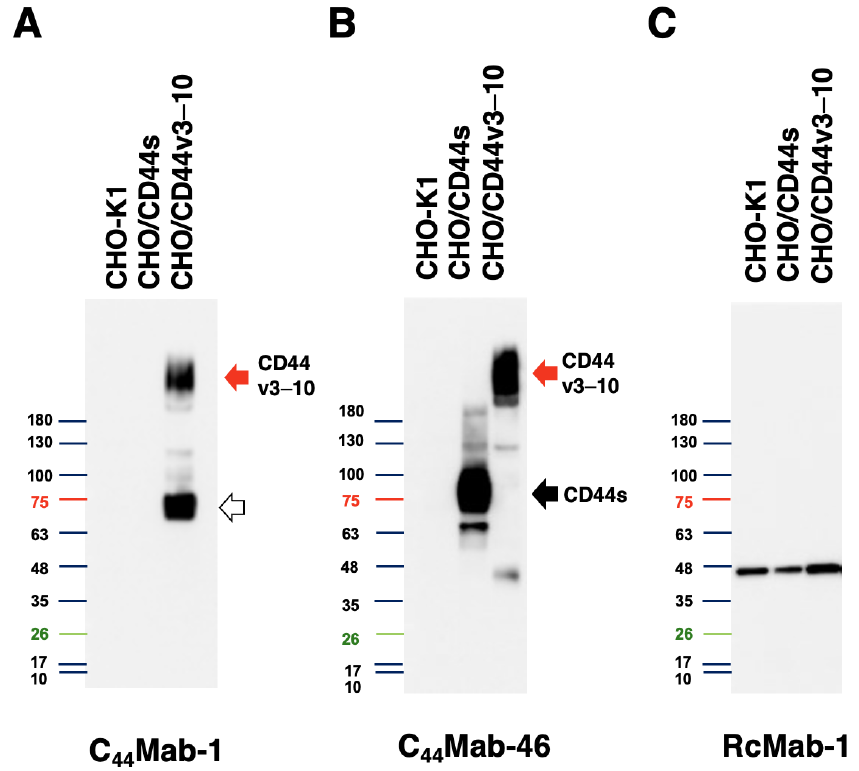
Figure 4. Western blot analysis by C 44 Mab-1. The total cell lysates (10 µ g of protein) were separated and transferred onto polyvinylidene difluoride (PVDF) membranes. The membranes were incubated with 10 µ g/mL of C 44 Mab-1 ( A ), 10 µ g/mL of C 44 Mab-46 ( B ), or 1 µ g/mL of RcMab-1 ( C ), followed by incubation with peroxidase-conjugated anti-mouse (for C 44 Mab-1 and C 44 Mab-46) or anti-rat (for RcMab-1) immunoglobulins. The red arrows indicate the CD44v3–10 (>180 kDa). The black arrow indicates CD44s (~75 kDa). The white arrow indicates the lower molecular weight band rec- ognized by C 44 Mab-1 in CHO/CD44v3 – 10 lysate (~75 kDa).